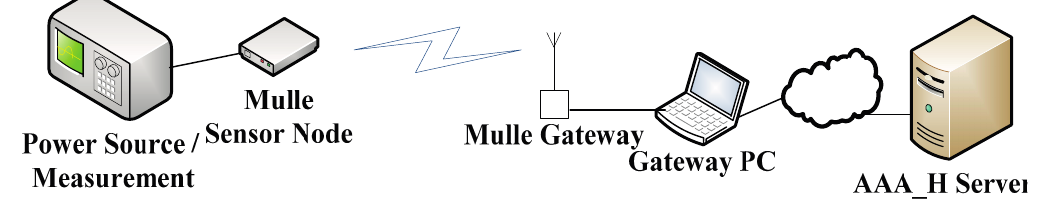
Figure 5. Experimental setup for sensor node power consumption measurement during the authentication